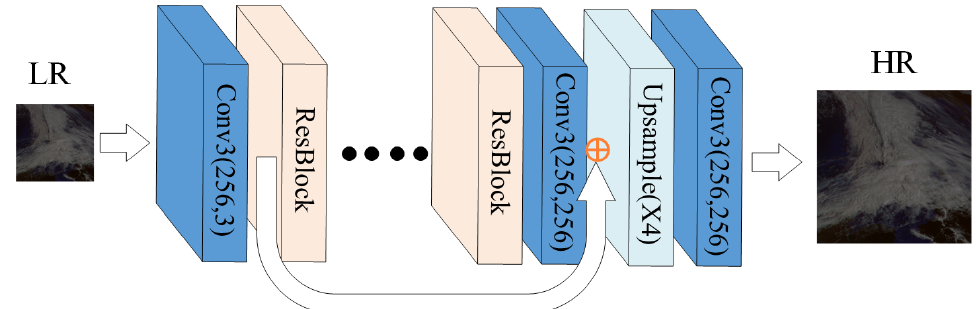
Figure 3. Structure of enhanced deep residual networks (EDSR).